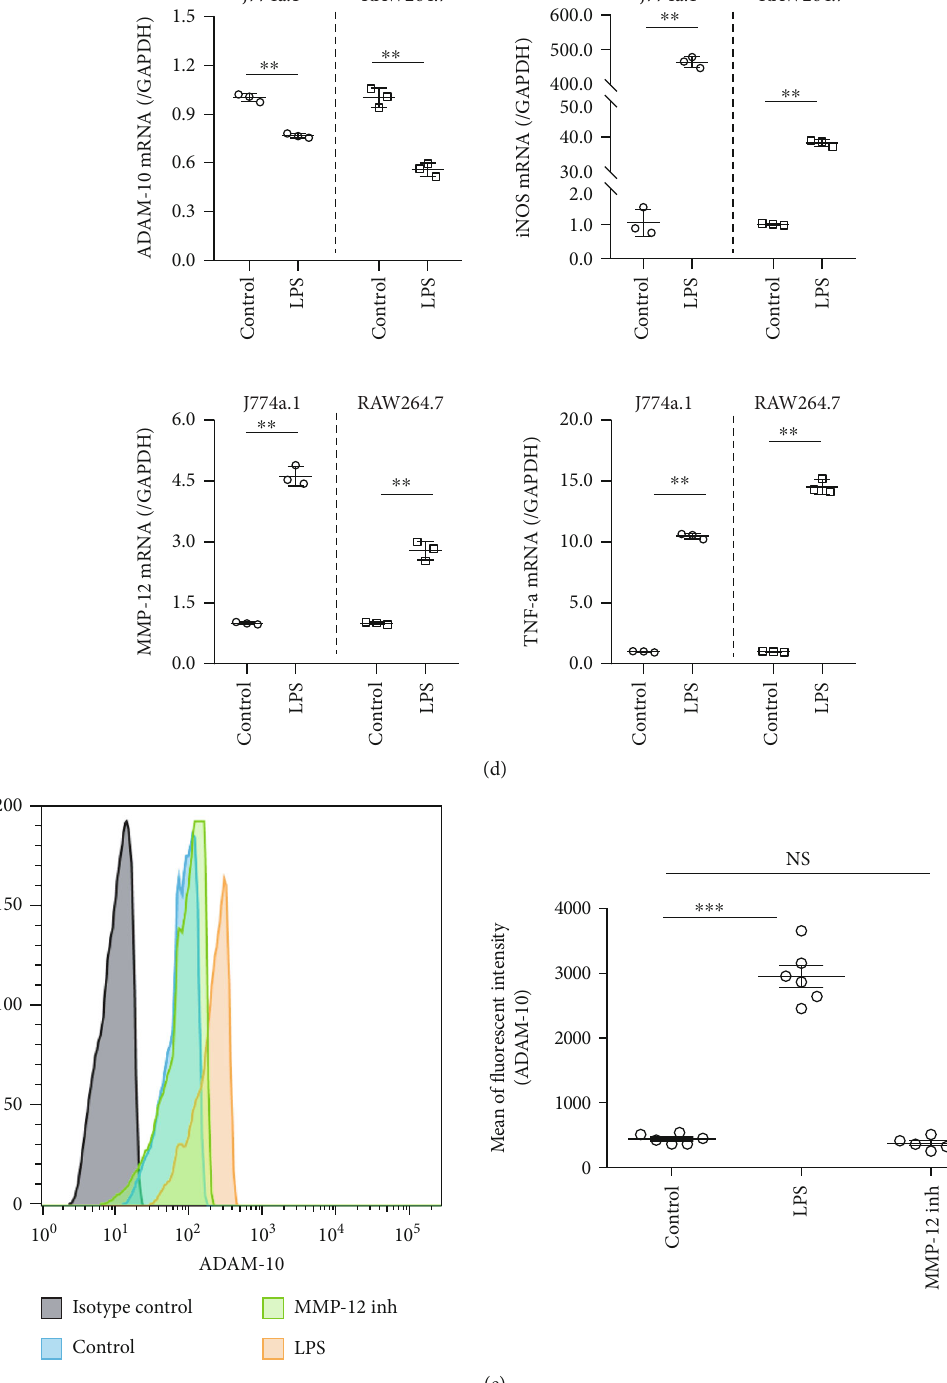
Figure 2: Lipopolysaccharide-promoted proliferation- (LPS-) induced in fl ammatory responses in macrophages a ff ect A disintegrin and metalloprotease 10 (ADAM-10) and matrix metalloproteinase 12 (MMP-12). (a) The upper bar graph shows increased cell viability induced by LPS; the lower bar graph shows that MMP-12 inhibition had no signi fi cant e ff ect on cell viability. Each group contained six samples. (b) The upper dot plot indicates LPS-inhibited ADAM-10 mRNA synthesis, determined by qualitative PCR (qPCR), with each dot representing one read. The lower bar graph shows increased secretion of ADAM-10 proteins by LPS, as determined by enzyme- linked immunosorbent assay (ELISA); each group containing four wells. (c) LPS stimulated ADAM-10 and MMP-12 mRNA synthesis in a time-dependent manner. Each dot represents a readout. (d) The e ff ect of LPS (1 μ g/ml, 12h) on ADAM-10 , MMP-12 , iNOS , and TNF- α transcript levels in J774a.1 and RAW246.7 cells. Each dot represents a readout. (e) Flow cytometry analysis indicated inhibition of MMP-12 which decreased ADAM-10